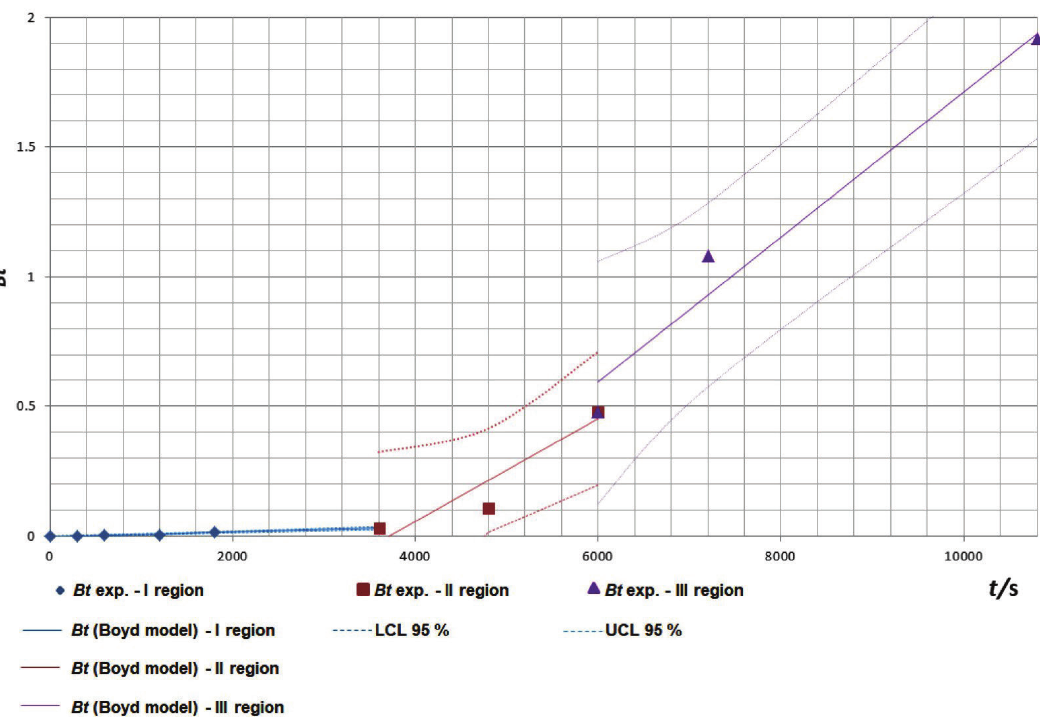
Fig. 6 – Experimental and model Boyd plot of vitamin E encapsulation with w 6 g zeolite